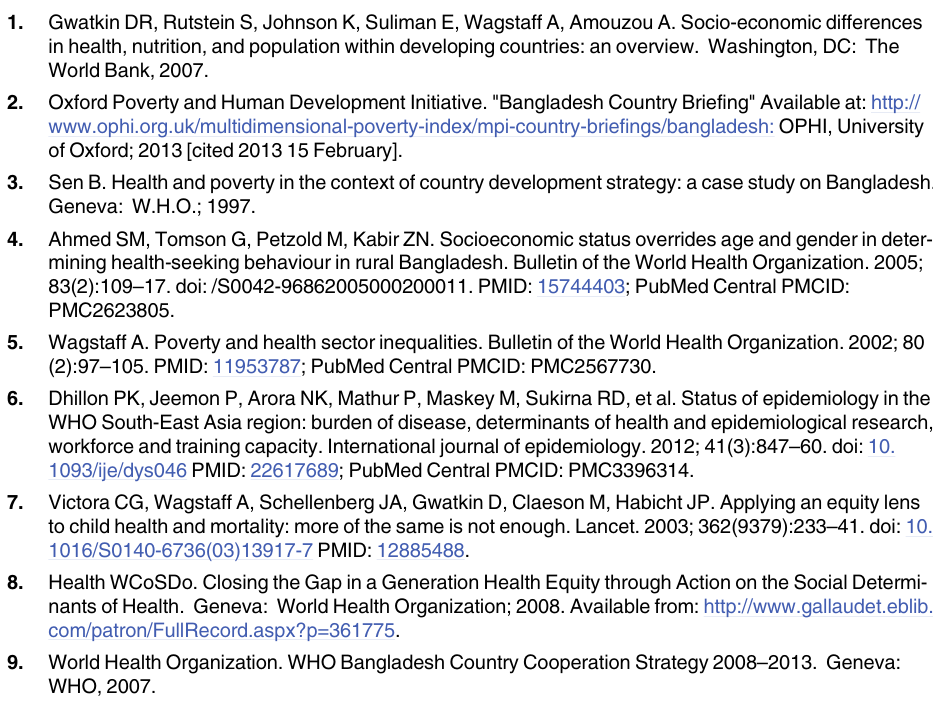
S1 Table. Transitions between sources of healthcare undertaken by participants with AFI. S2 Table. Routes to the referral hospital, undertaken by 527 patients with AFI, beginning with the first source of help outside the home, and ranked for frequency of utilization. S3 Table. Means of transport to the referral